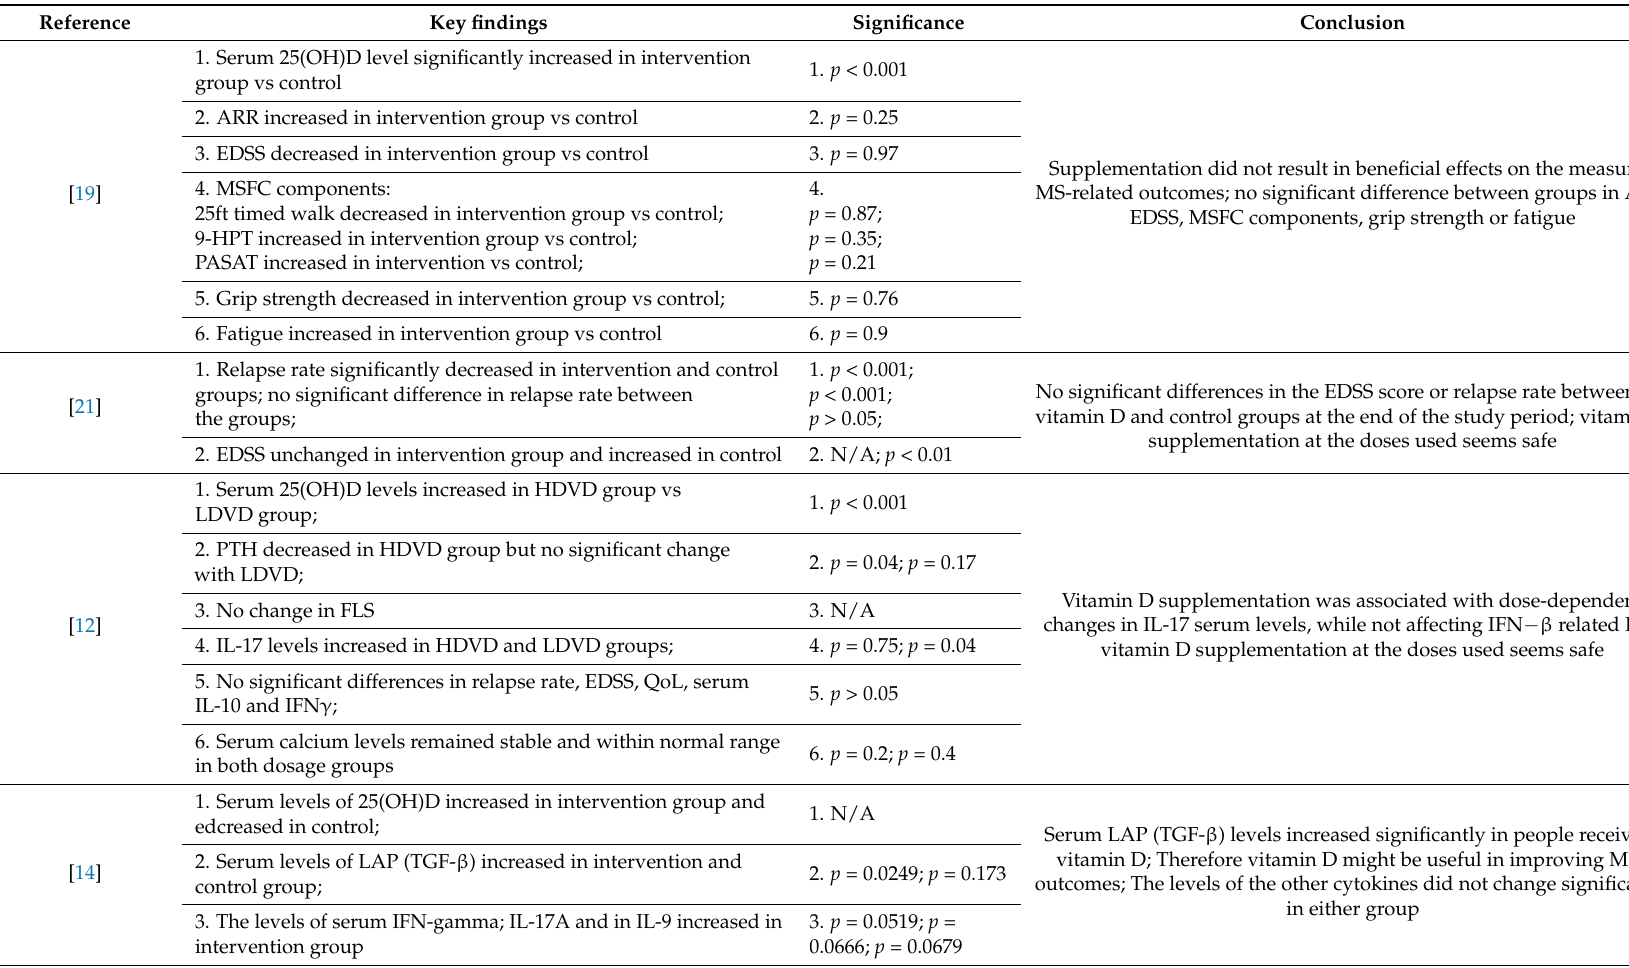
Table 5. Key findings of reviewed